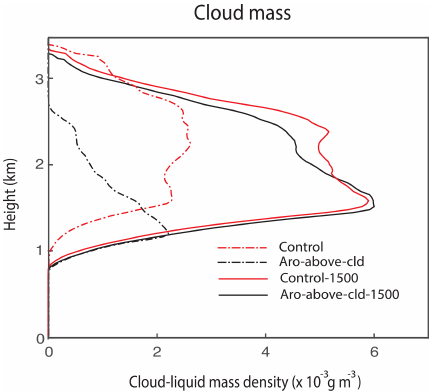
Figure 7. Vertical distributions of the time- and area-averaged cloud liquid mass density that represents cloud mass for the stan- dard simulations (i.e., the control, aro-above-cld, control-1500 and aro-above-cld-1500 runs).